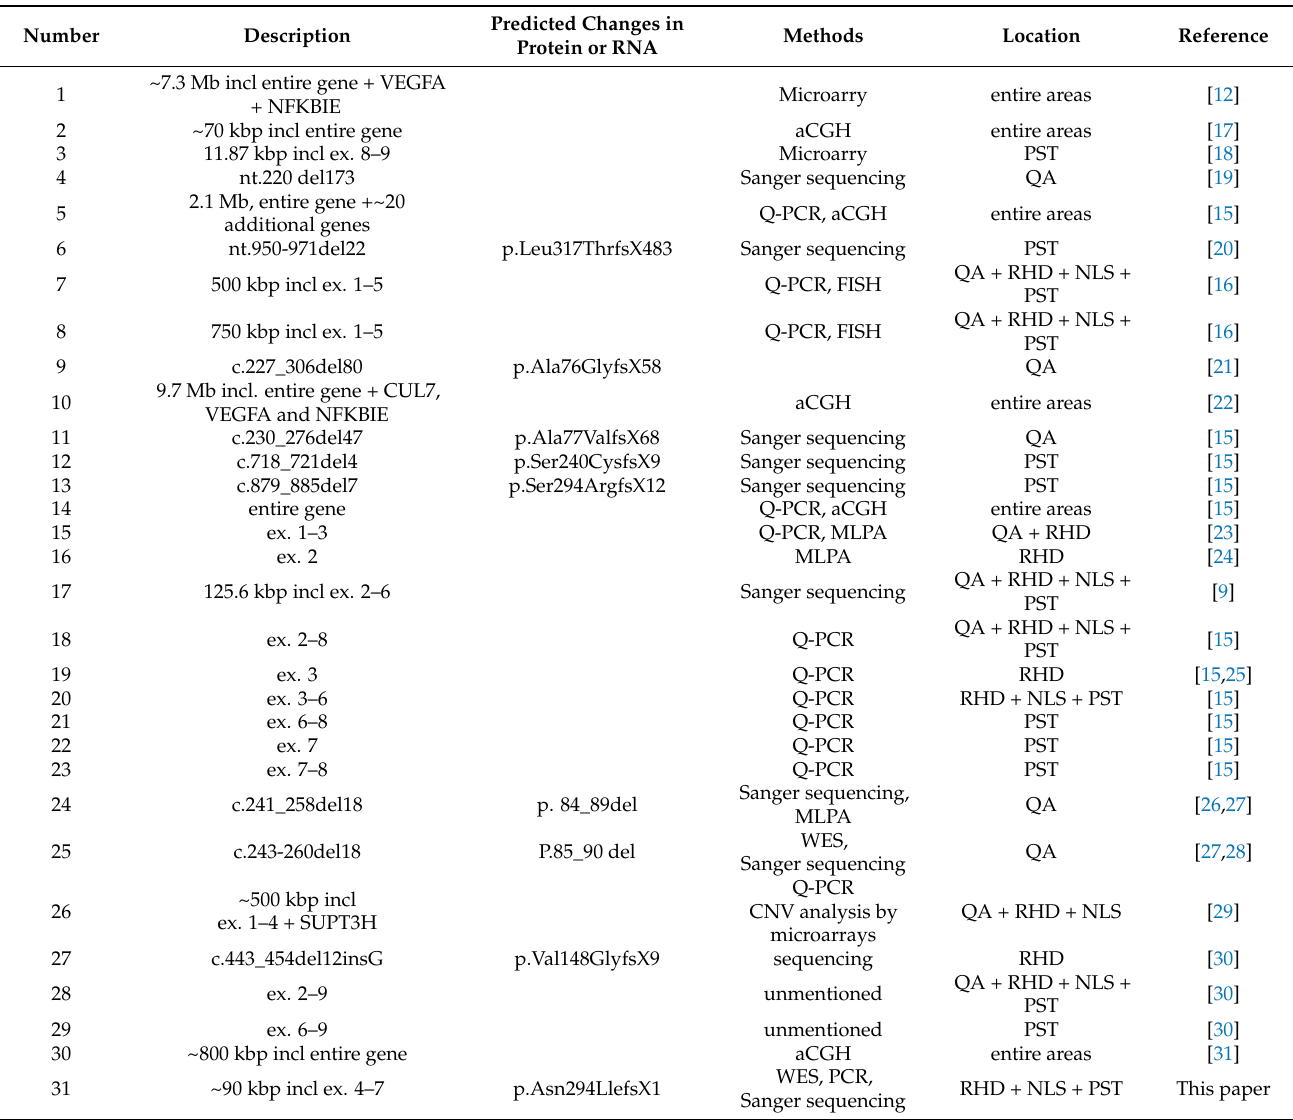
Table 1. Gross deletions in RUNX2